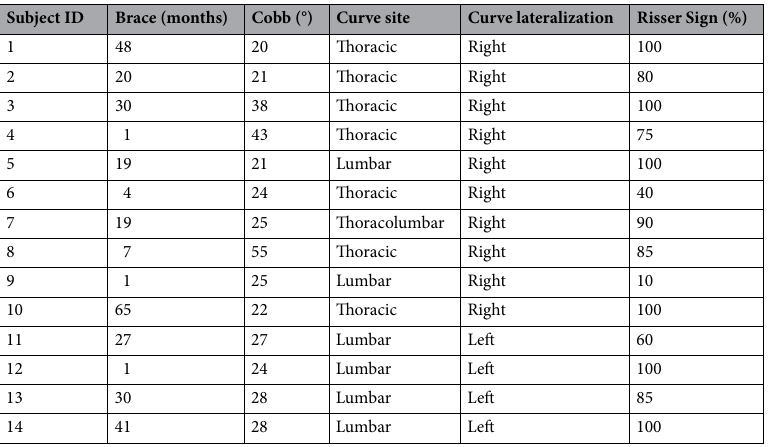
Table3. Anthropometric characteristic of adolescents with